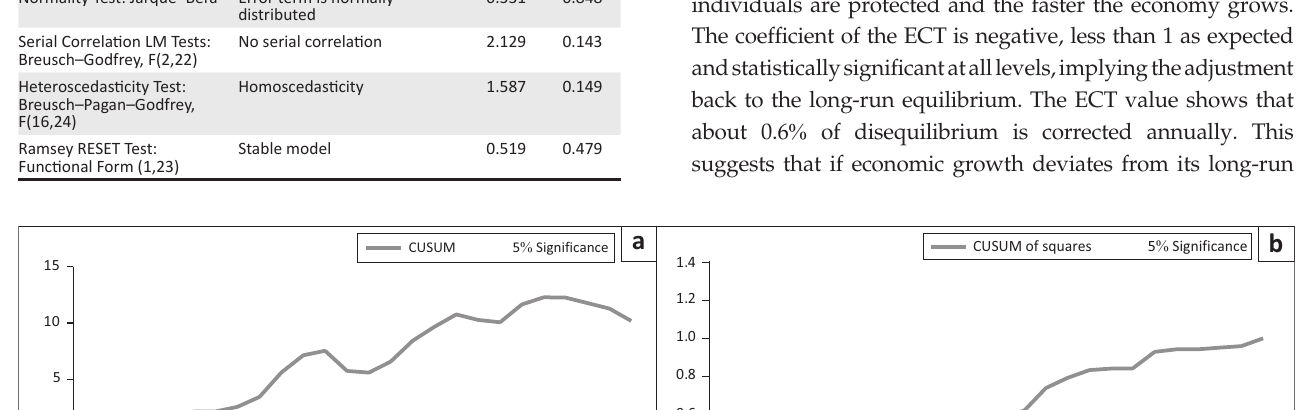
TABLE 7: Diagnostic tests. Test Null hypothesis